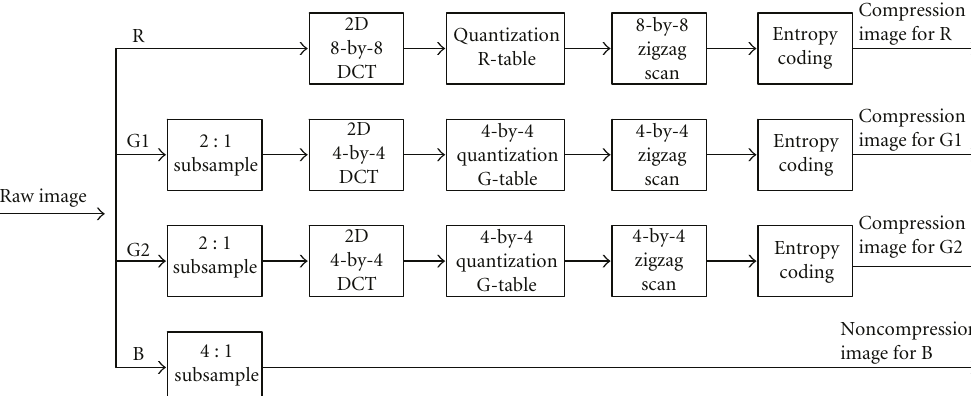
Figure 7: The GICam-II image compression